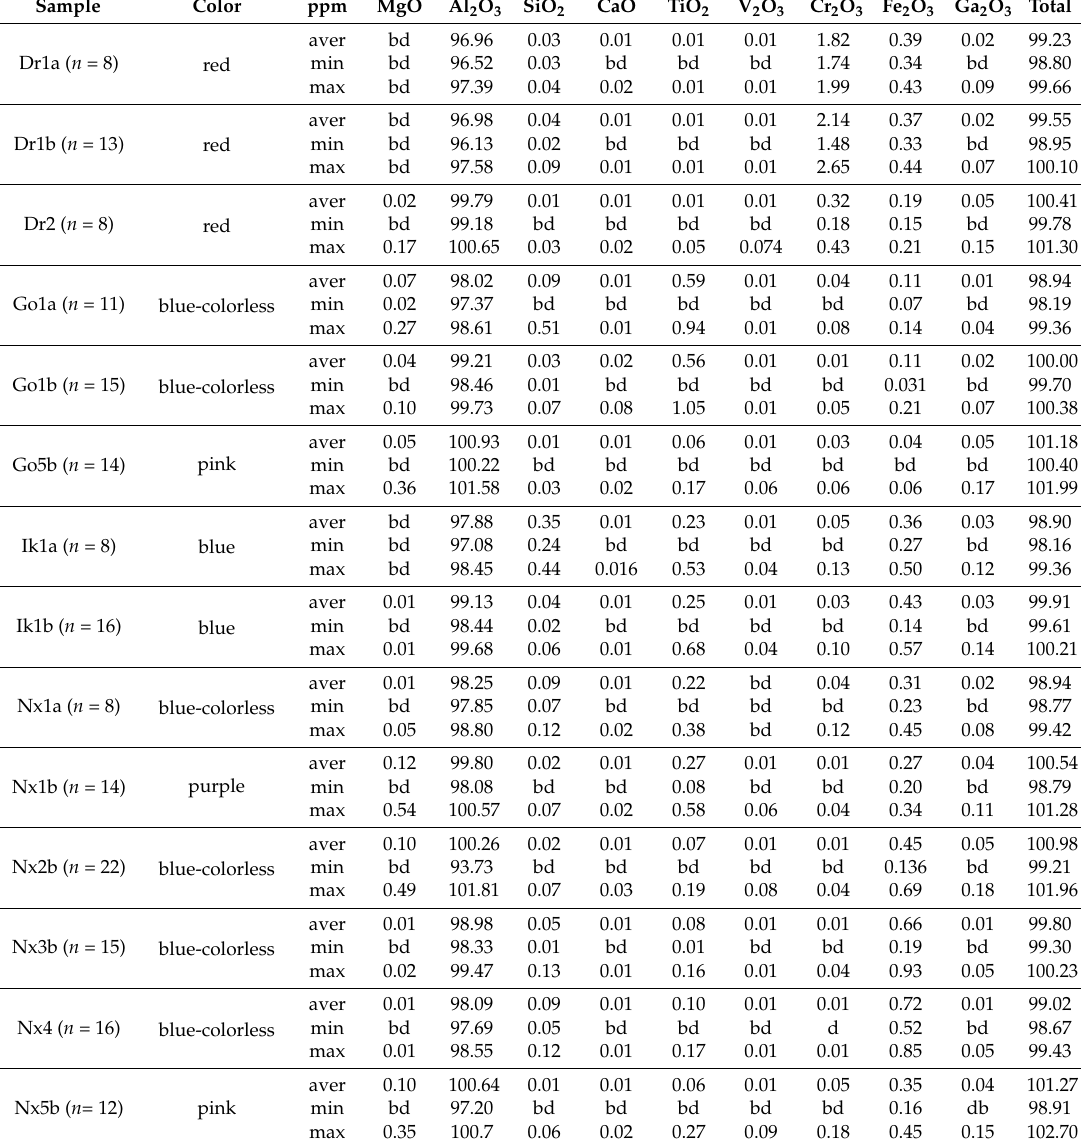
Table 2. Chromophores and key trace elements electron probe microanalyses (EPMA) (wt. %) of the Greek corundum